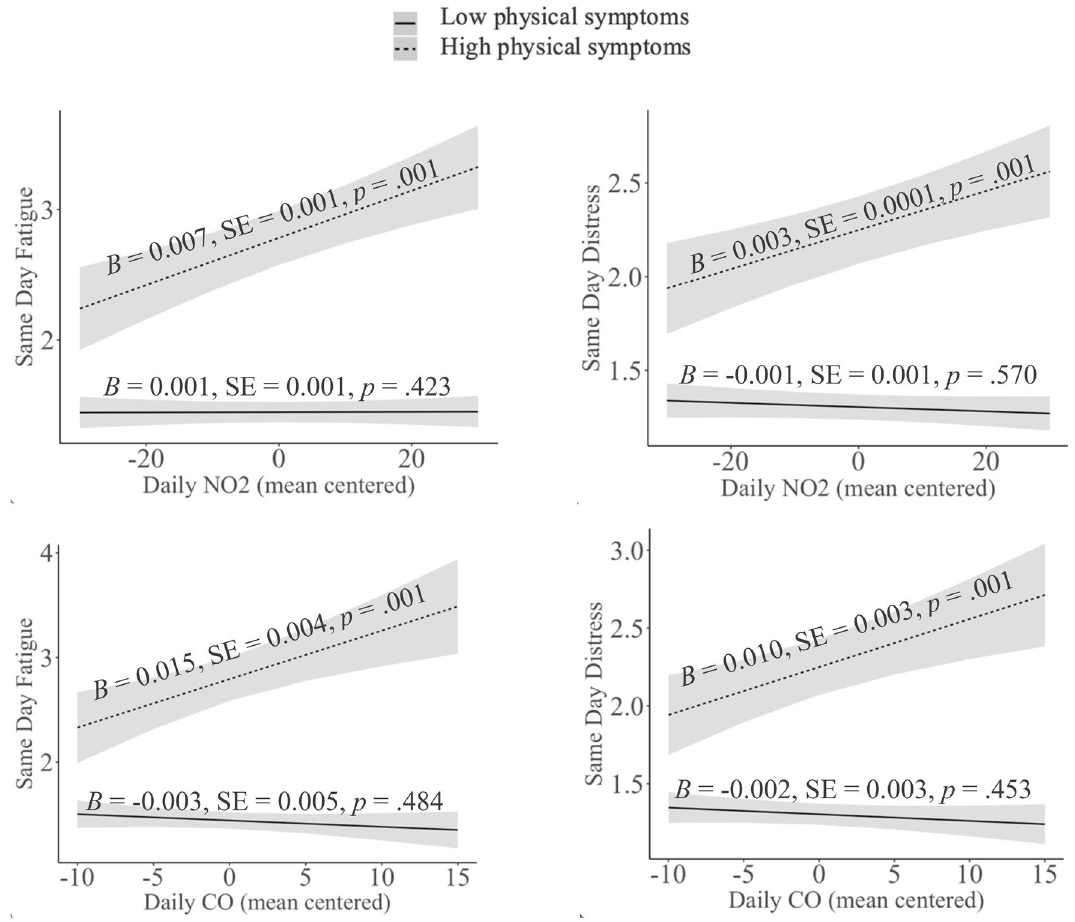
physical symptoms) but not among adolescents who report fewer ongoing physical symptoms for the year (− 1 SD below the mean level of physical